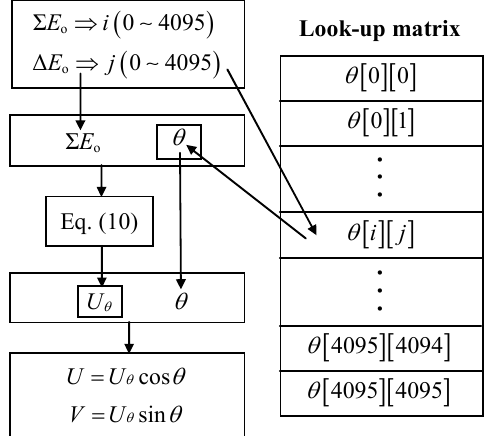
Fig. 4 Schematic diagram of look-up matrix